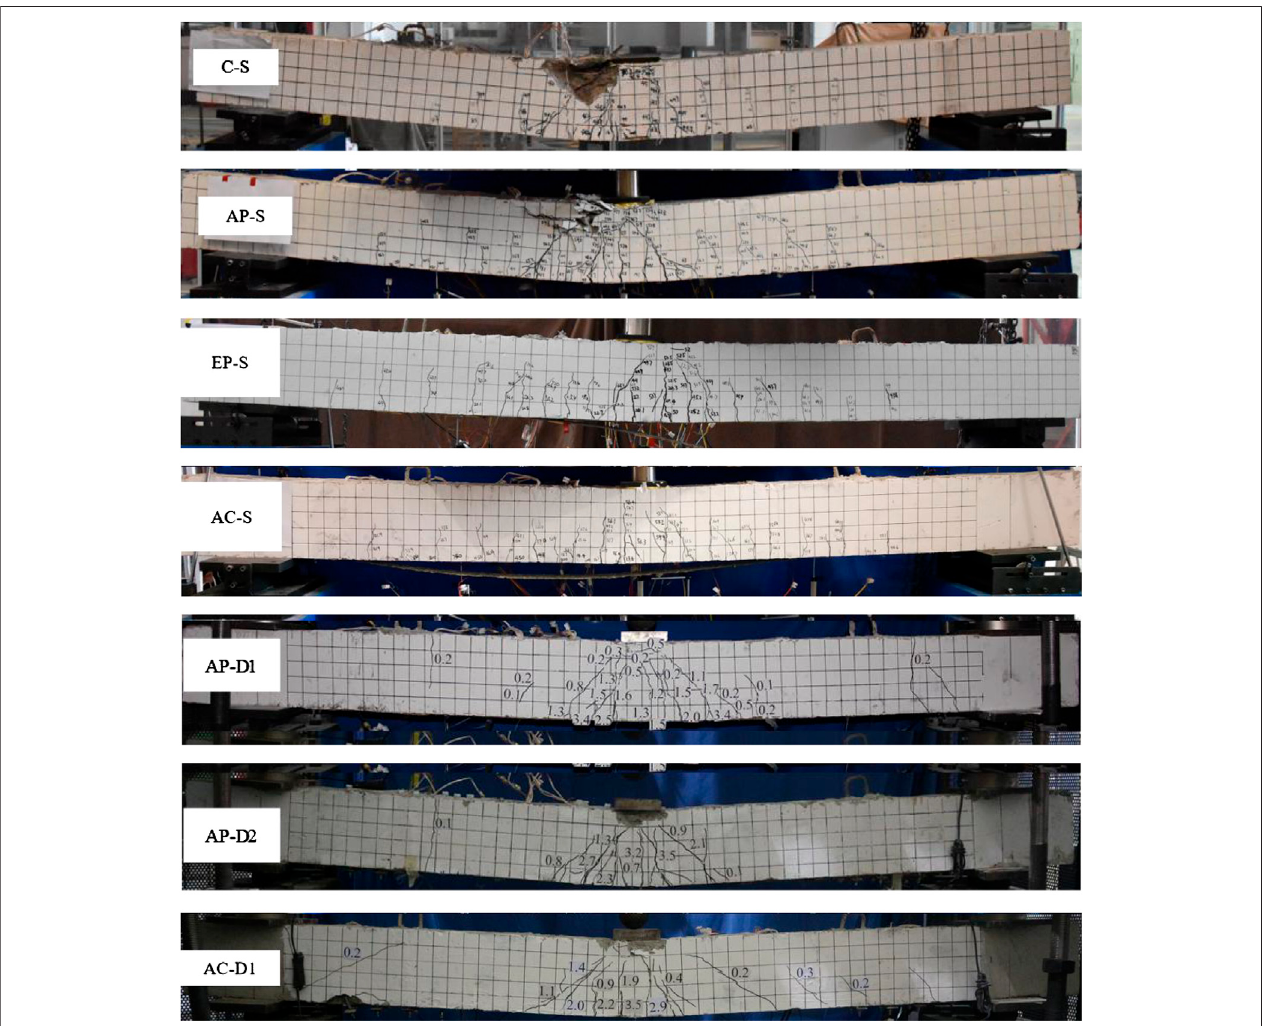
FIGURE 4 | Overall failure